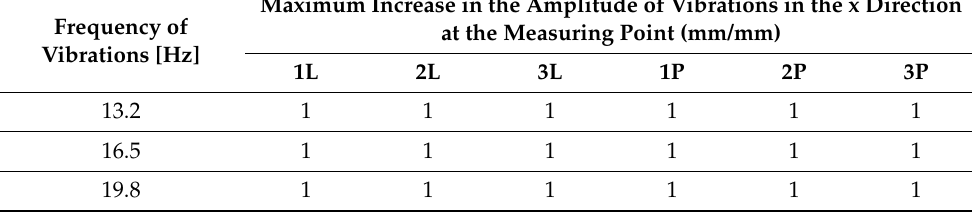
Table 1. Maximum multiples of vibration amplitudes in the x direction.